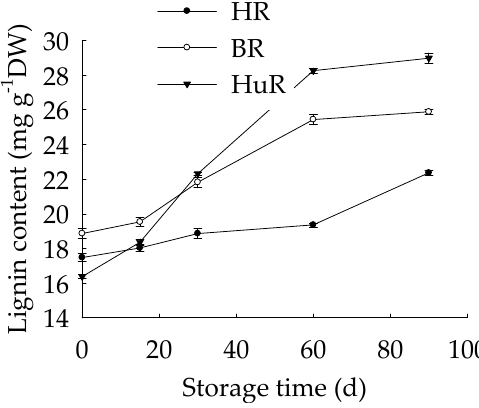
Figure 4. Changes in lignin content in juice sacs of three pumelo cultivars. Vertical bars represent SE of the means of three replicate assays. DW, dry weight.